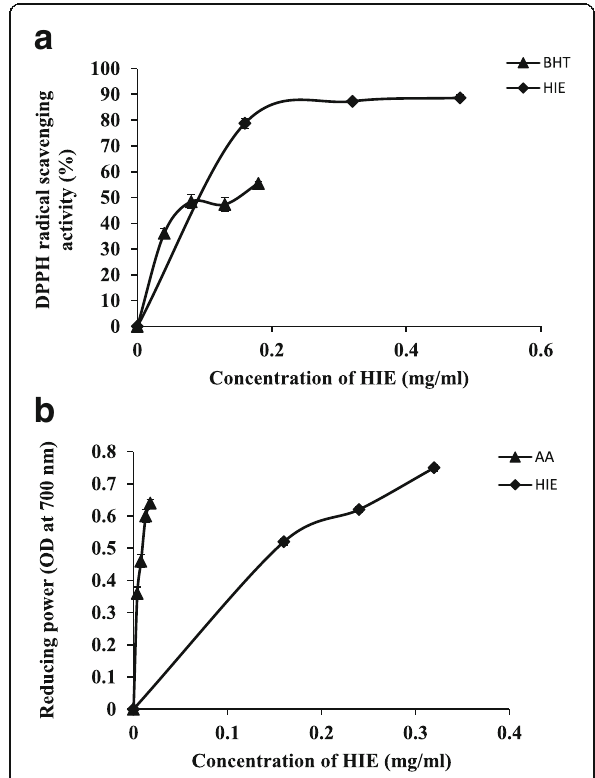
Fig. 3 Effect of different concentration of HIE on ( a ) DPPH radical scavenging activity; ( b ) Reducing power. Values are Mean ± SE of